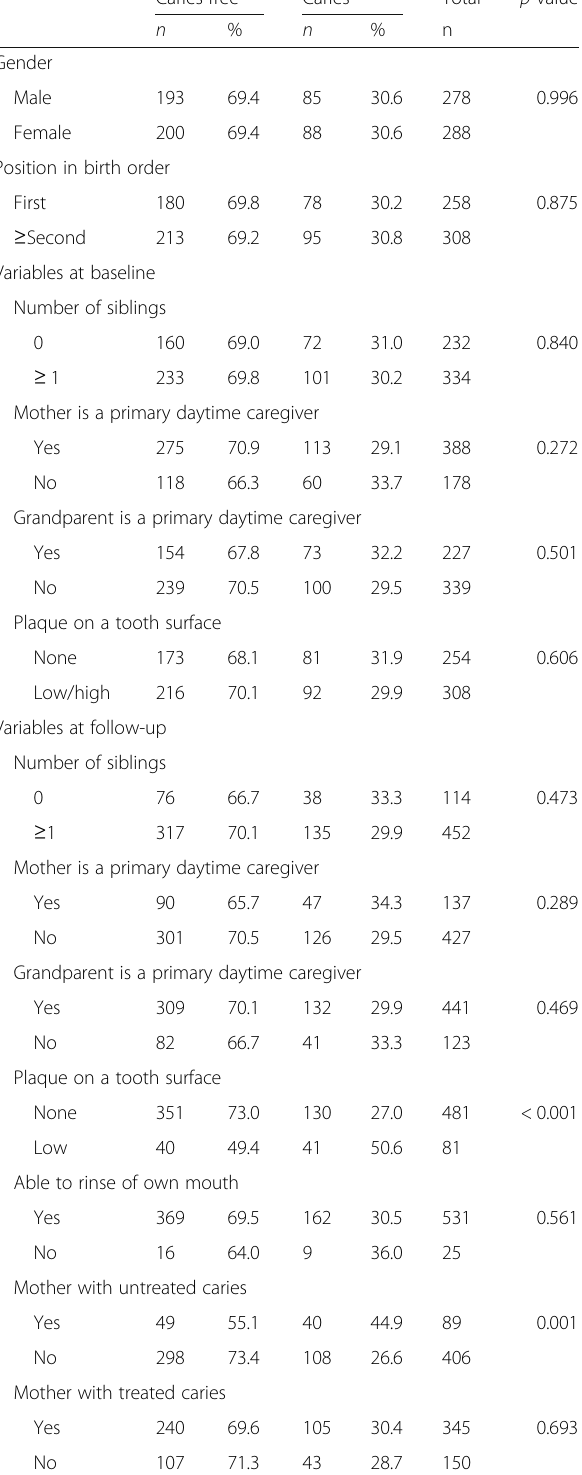
Table 3 Characteristics, dental condition, caregivers status and caries at follow-up ( n = 566)